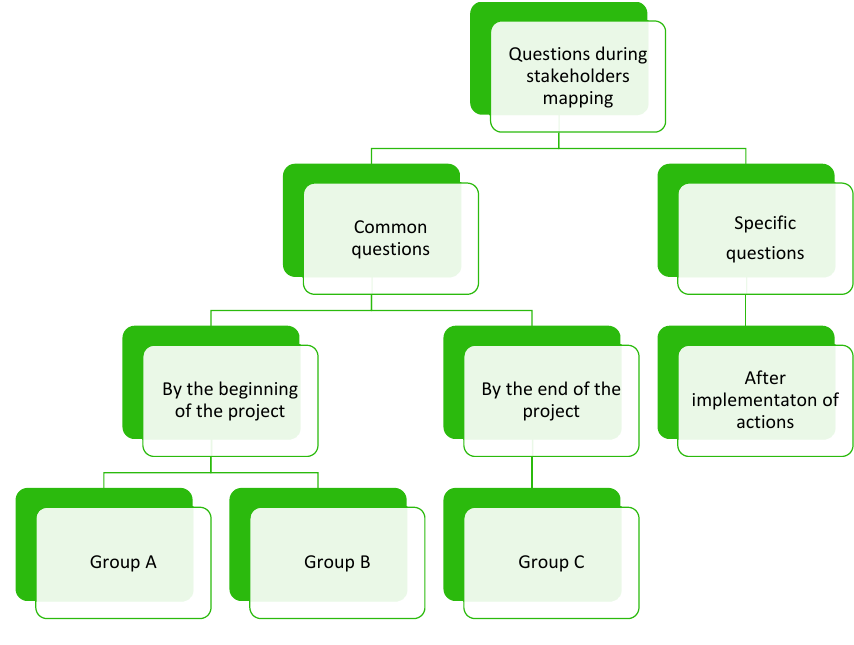
Figure 2. Data collection protocol